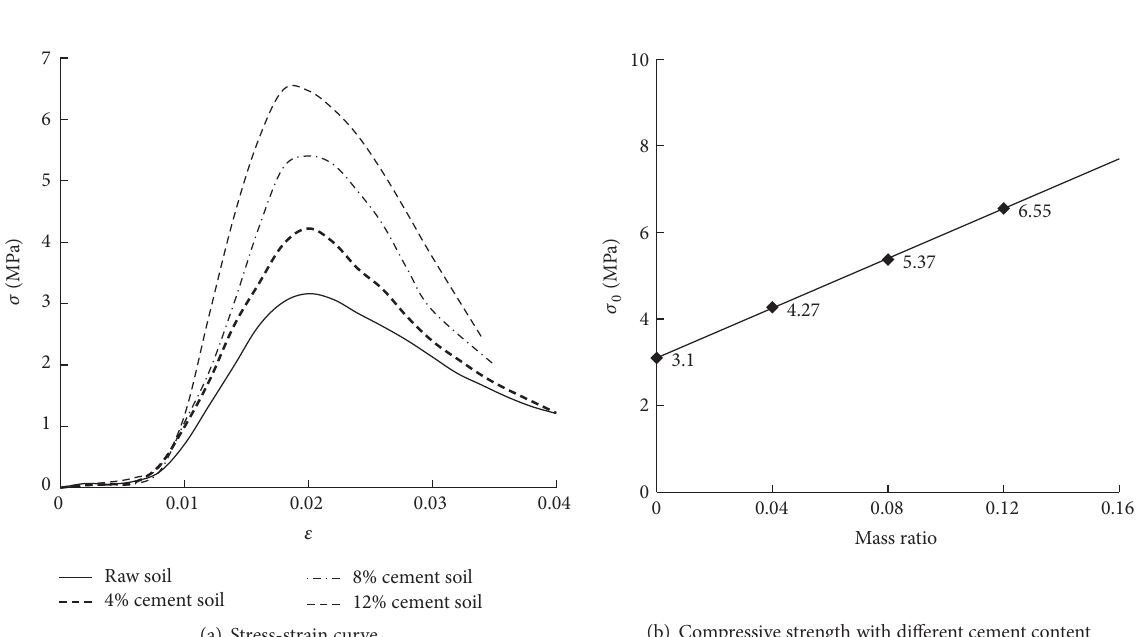
Figure 11: Relationships between stress-strain and cement